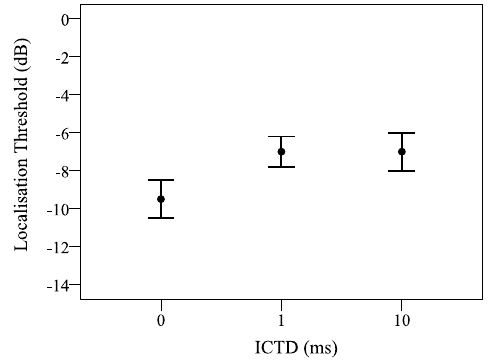
Figure 7. Localisation thresholds for combined sources.